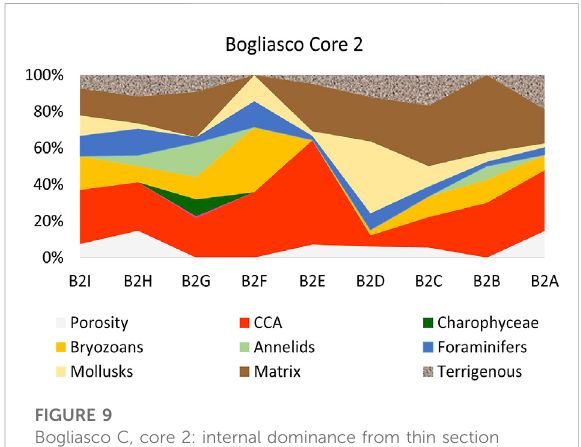
FIGURE 9 Bogliasco C, core 2: internal dominance from thin section point counting of the categories as in Table 4. The label of the studied thin sections is reported on the horizontal axis.